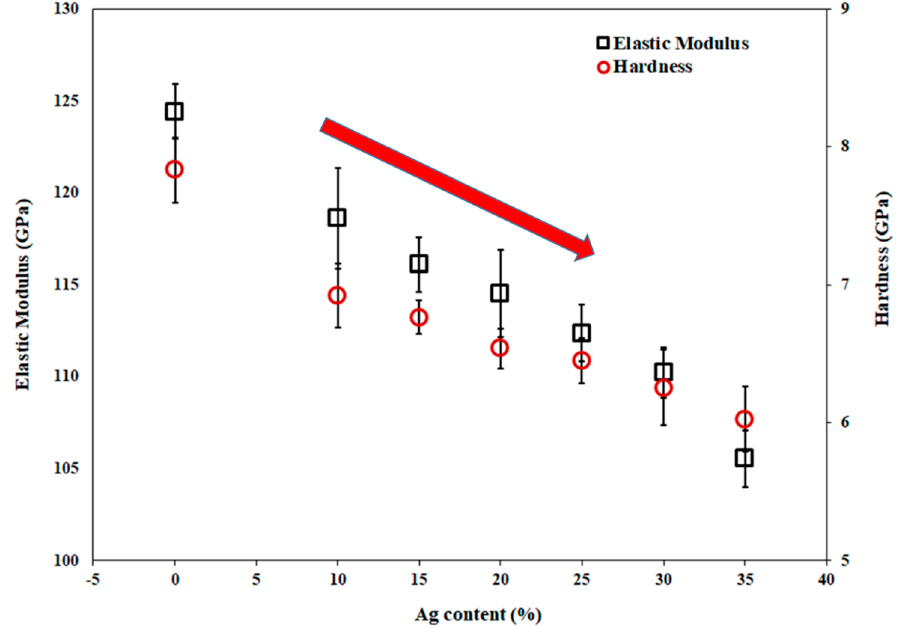
Figure 6. Elastic modulus and hardness of the Ti-Cu and Ti-Cu-Ag thin films as a function of the Ag content.